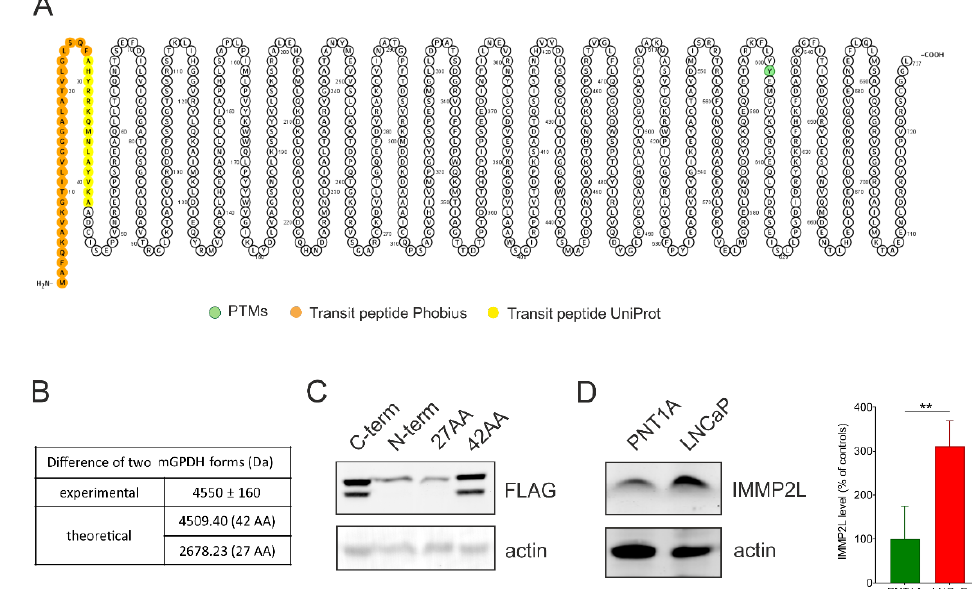
Figure 2. Analysis of mGPDH forms. ( A ) mGPDH topology by the Protter visualization tool. Predicted phosphorylation (green) and targeting sequences by Uniprot (yellow) and Phobius (orange) are depicted. ( B ) Table of experimental and calculated differences of two mGPDH forms. Experimental difference ( n = 5) was determined by the Molecular Weight Analysis tool (Image Lab software, Bio-Rad). ( C ) Cell lysates (50 μg protein) of HEK293 cells overexpressed with FLAG in different places of the GPD2 sequence were separated on SDS-PAGE (Hoefer System) and mGPDH forms were analyzed by Western blot using a specific antibody against FLAG ( n = 3). C-term—GPD2 with FLAG tag at the C-terminal, N-term—GPD2 with FLAG following initial start codon (N-term), 27AA—GPD2 with FLAG tag following 27th amino acid and 42AA—GPD2 with FLAG tag following 42nd amino acid. ( D ) Cell lysates (15 μg protein) of control PNT1A and cancer (LNCaP) cells were separated on SDS-PAGE and IMMP2L peptidase content was analyzed by Western blotting using a specific antibody ( n = 5). Actin was used as a loading control ( C–D ). Data represent the means ± S.D., ** p < 0.01.